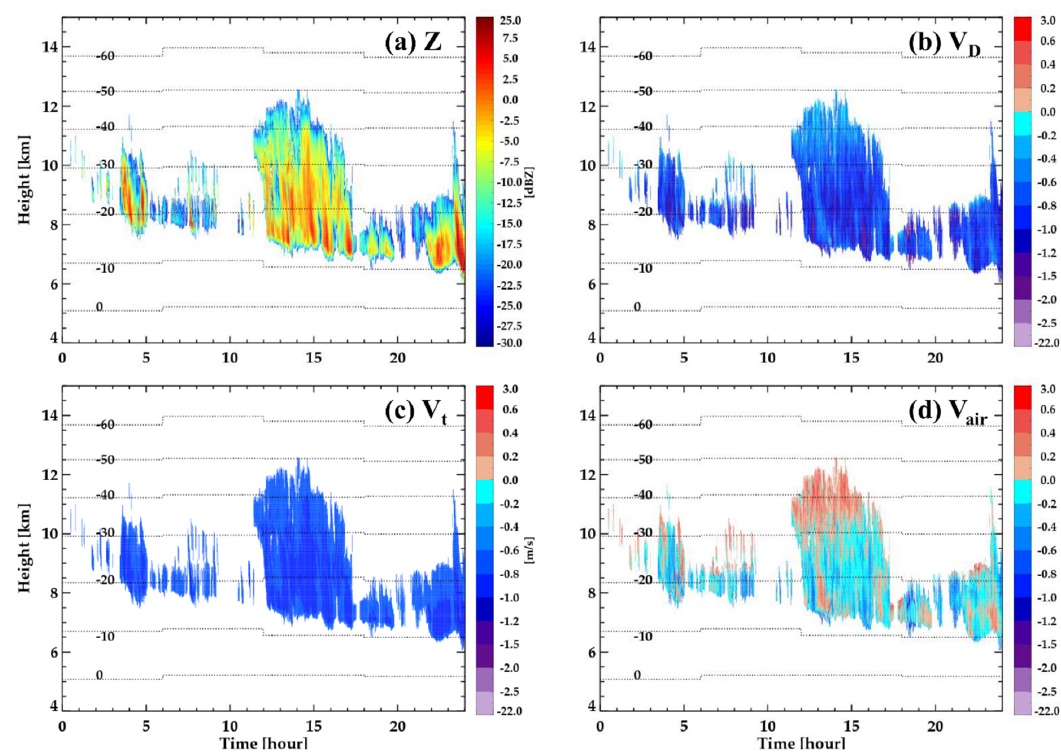
Figure 10. Time–height cross-sections of ( a ) observed Z , ( b ) observed V D , ( c ) V t retrieved from V t – Z relationship of cirrus, and ( d ) retrieved vertical air motion ( V air ) of a case of cirrus on 9 August 2015. Dotted line is temperature from sounding data.